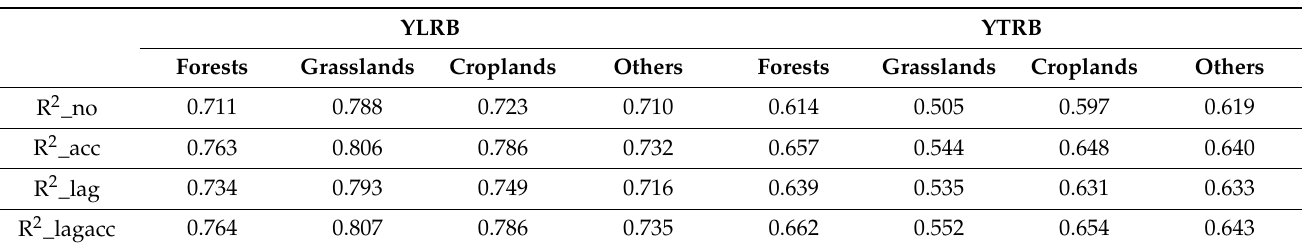
Table 5. Determination coefficients of multiple linear regression models for different vegetation types in different scenarios. YLRB YTRB Others Forests Grasslands Croplands